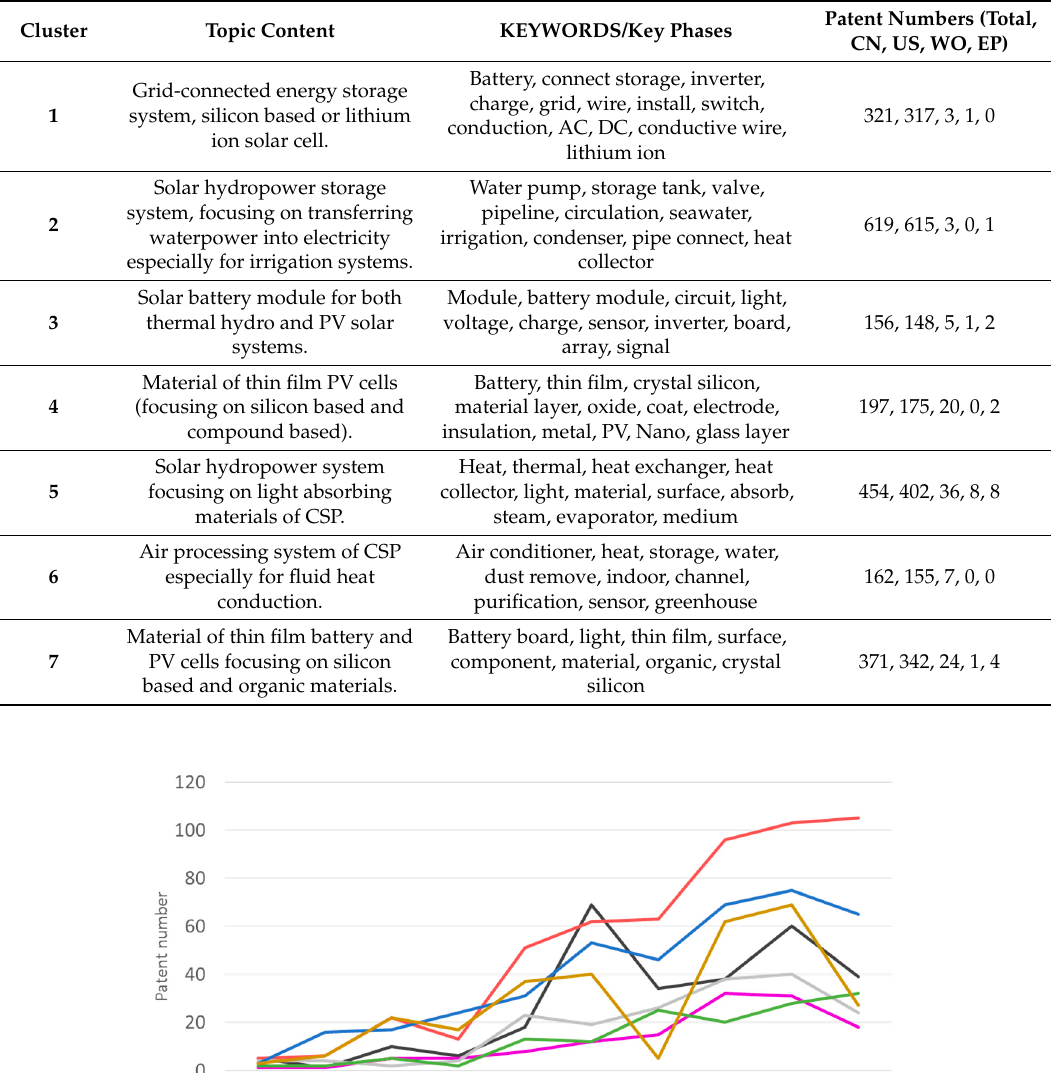
Table 2. Description of the patent clusters.